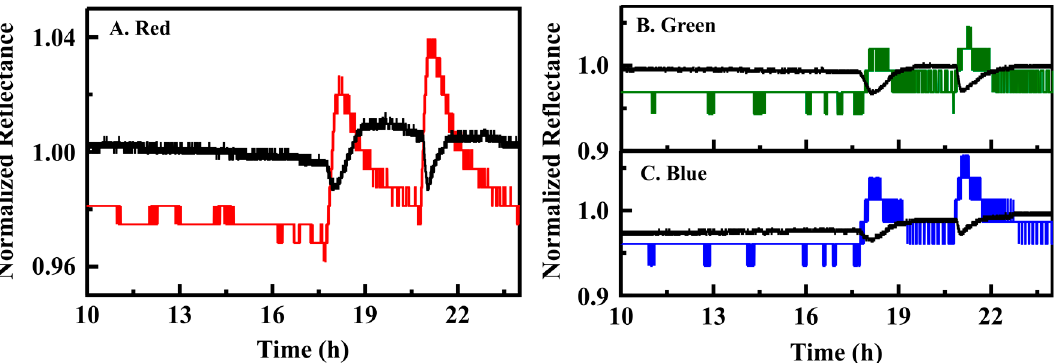
Figure 3. PT3 data at a 5 s sampling interval (100 ms integration; PT3; black) compared to 100 ms PT5 data (RGB, 5 s sampling interval). The two exposures shown here were completed in the glove enclosure using a maximum ethanol concentration of 1.06 ppm. Table 1. ROC comparison for algorithms applied to PT3 data collected using either Petri dish or glove enclosure exposures. Analysis of PT5 data collected at 100 ms with a 5 s sampling interval is also included.